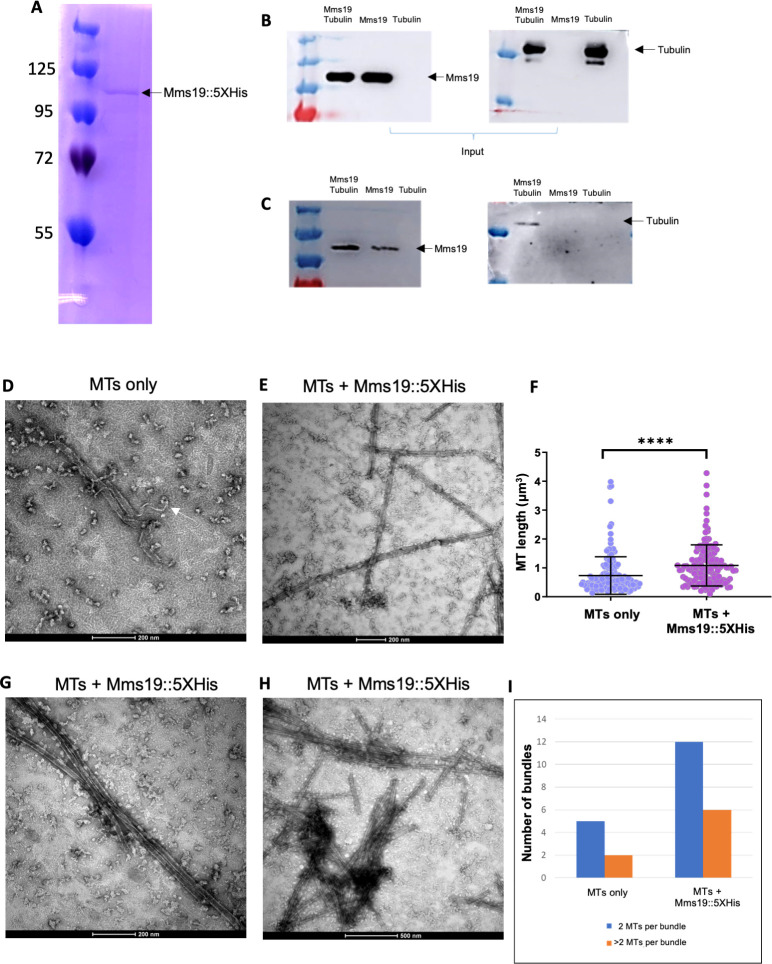
Mms19::5xHis binds to tubulin and stimulates MT assembly in vitro.(A) Mms19 tagged with 5X Histidine was purified from E. coli. A single band at approximately 100KDa is seen when the purified protein fraction is separated by SDS-PAGE and stained with Coomassie Blue. Mms19::5xHis-tubulin interaction was investigated using a pull-down assay with Ni-NTA resin. Tubulin binding to Mms19::5xHis is expected to result in co-purification of tubulin with Mms19::5xHis. (B) Input panels show tubulin added, either alone or with Mms19. (C) Tubulin was found binding to the resin only upon prior incubation with Mms19::5xHis (tubulin added alone did not bind to the resin). (D) MTs only (without Mms19::5xHis added) were visualized by negative stain EM. Here, an MT fiber can be seen depolymerizing (indicated by arrow). (E) In an MT-Mms19::5xHis mixture, discreet particles can be seen binding laterally along the surface of MTs. (F) Measuring the length of MT fibers revealed that MTs were generally longer when incubated together with Mms19::5xHis compared to MTs to which only the BRB80 buffer was added. n = 150 MTs per condition, 3 experiments, ss was calculated using student’s t-test, ****P<0.0001. MT bundles containing 2 (G) or more than 2 MTs (H) were more frequently observed upon the addition of Mms19::5xHis to MTs. The number of bundles observed in each condition is quantified in (I).